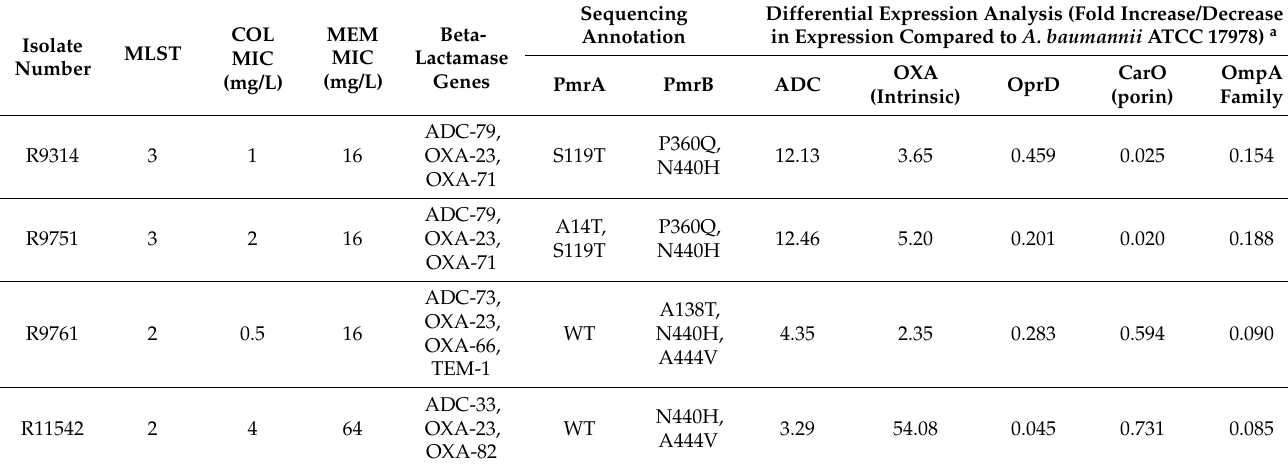
Table 2. Whole genome sequence results for 4 of the 5 isolates that were not responsive to the COL+MEM combination therapy.